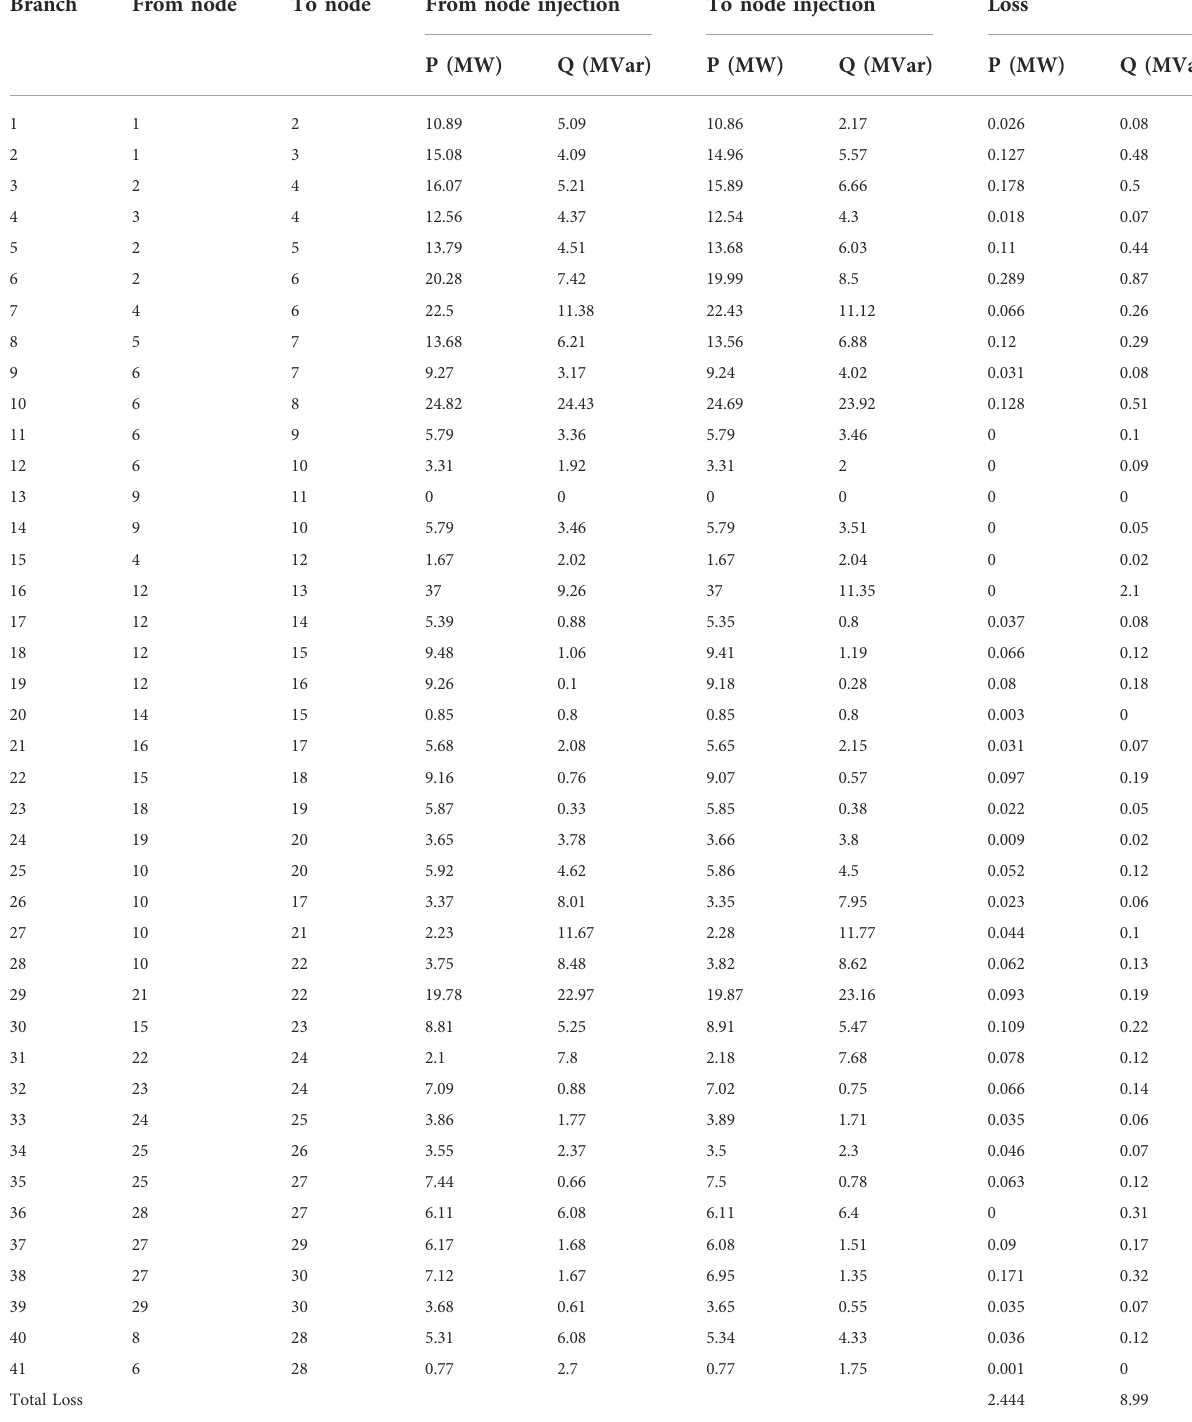
TABLE 4 The power transmitted on each